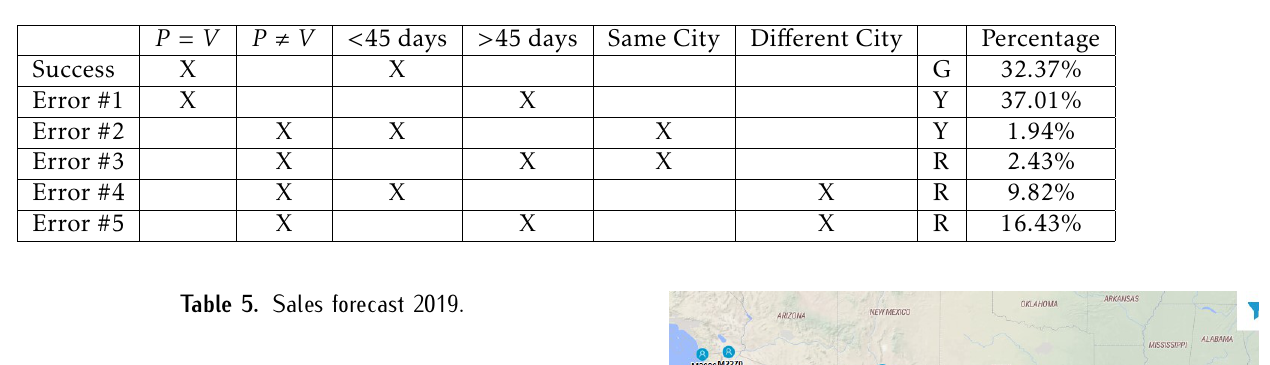
Table 4. Success and error table.